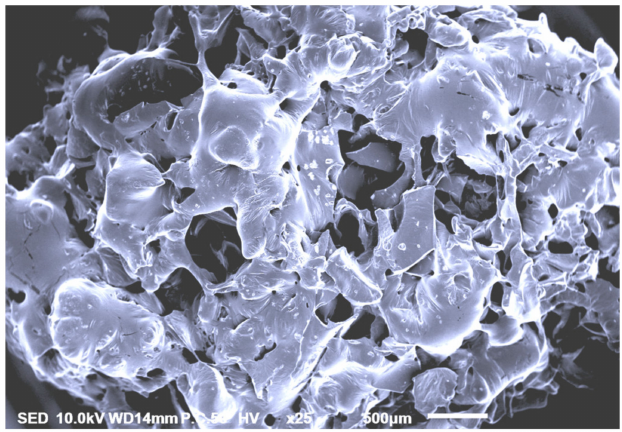
Figure 6. Scanning electron microscopy (SEM) image of papain-generated hydrolysates from Actinopyga lecanora